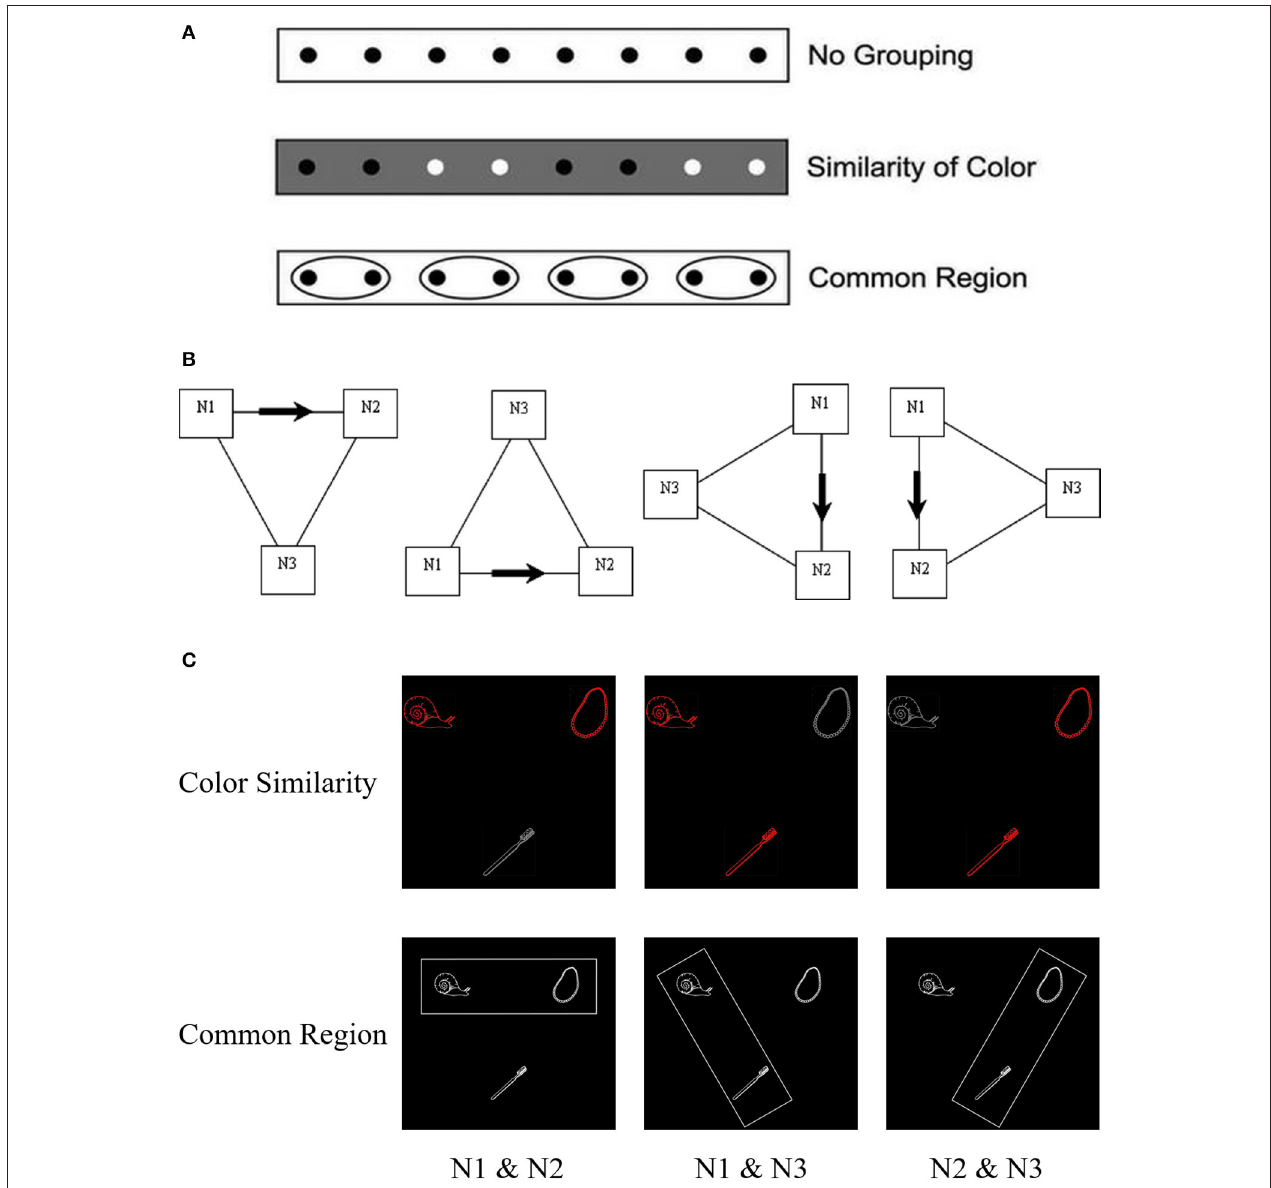
FIGURE 1 | Examples of (A) grouping principles, (B) the spatial configuration of objects in displays, and (C) examples of displays used in Experiments 1 and 2. (A) Illustration of grouping principles as similarity of color and common region (adapted from Palmer, 2002). (B) The four kinds of location relationships among the three pictures: above, below, right, and left (The arrows indicate the directions of description. Neither of the boxes, arrows, or lines was provided as part of the visual array. See the same presentation in Yang and Yang, 2008). (C) Example displays in the “above” location to be described with the sentence “the snail and the necklace are above the toothbrush” in the three grouping conditions of color similarity (Experiment 1) and common region (Experiment